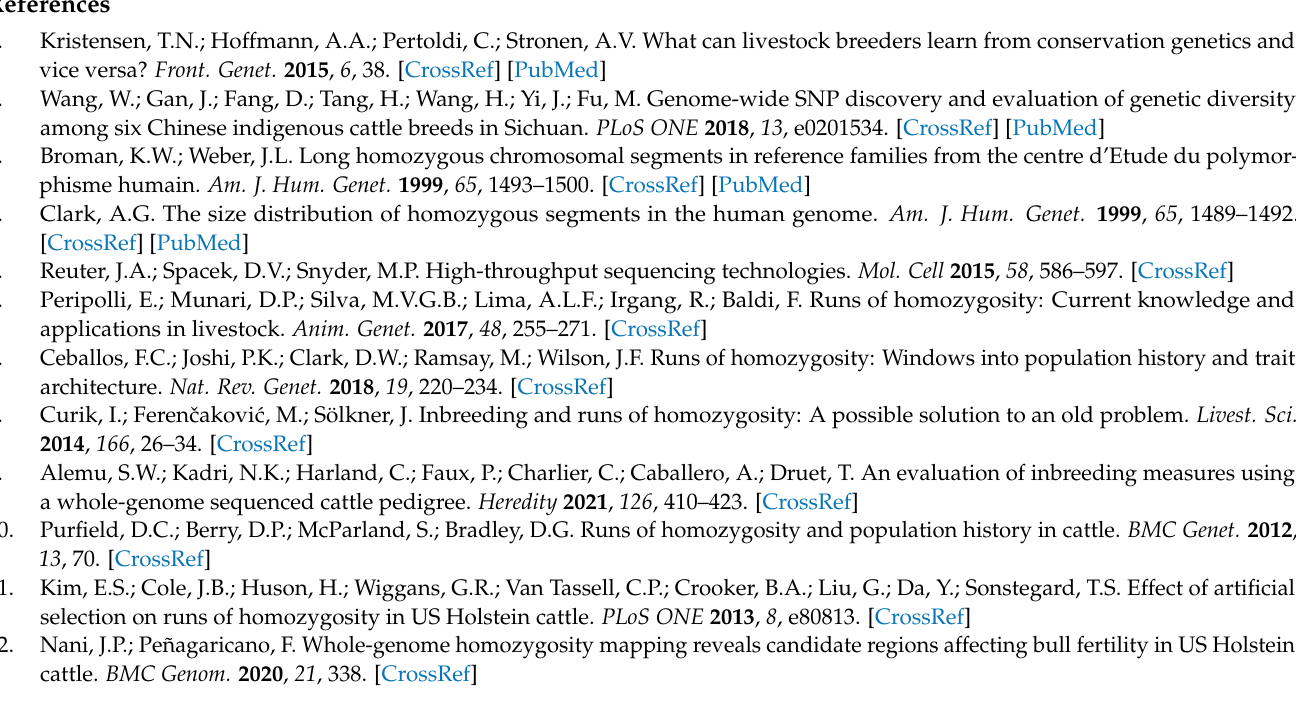
Table S2: Mapping results of clean reads against reference genome; Table S3: The related information of candidate